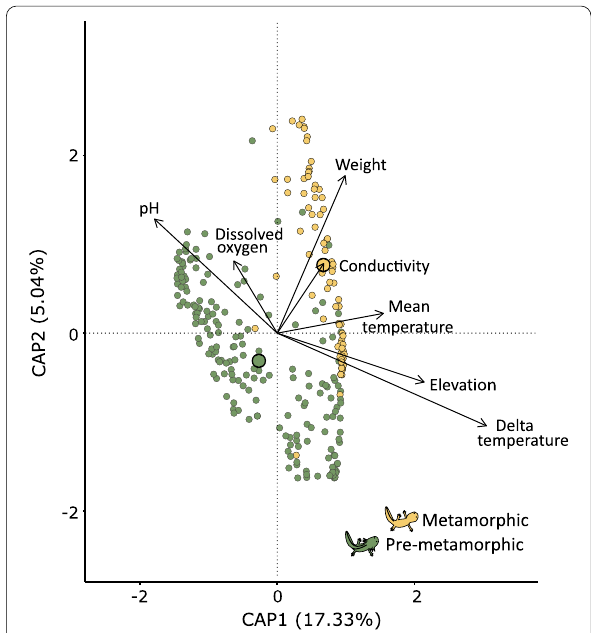
Fig. 5 Distance based redundancy analysis of A. altamirani skin bacterial communities. Distances in the PCA are based on a weighted UniFrac distance matrix. Vector directions indicate the type of correlation of each predictor variable. Distance of each sample with respect to vectors highlight the weight of the correlation with a given predictor variable. Non quantitative variables are represented as centroids (outlined circles larger). Circles are color‑coded by host metamorphic status